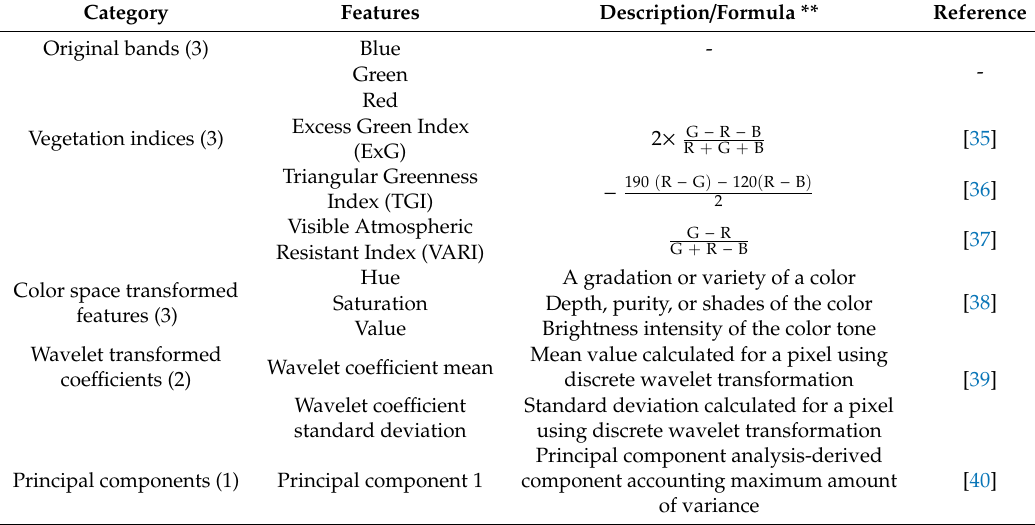
Table 1. Details of various features extracted and / or computed for image classification, through several computational procedures on the pixel value of imageries. The value in parenthesis indicates number of features belonging to the feature